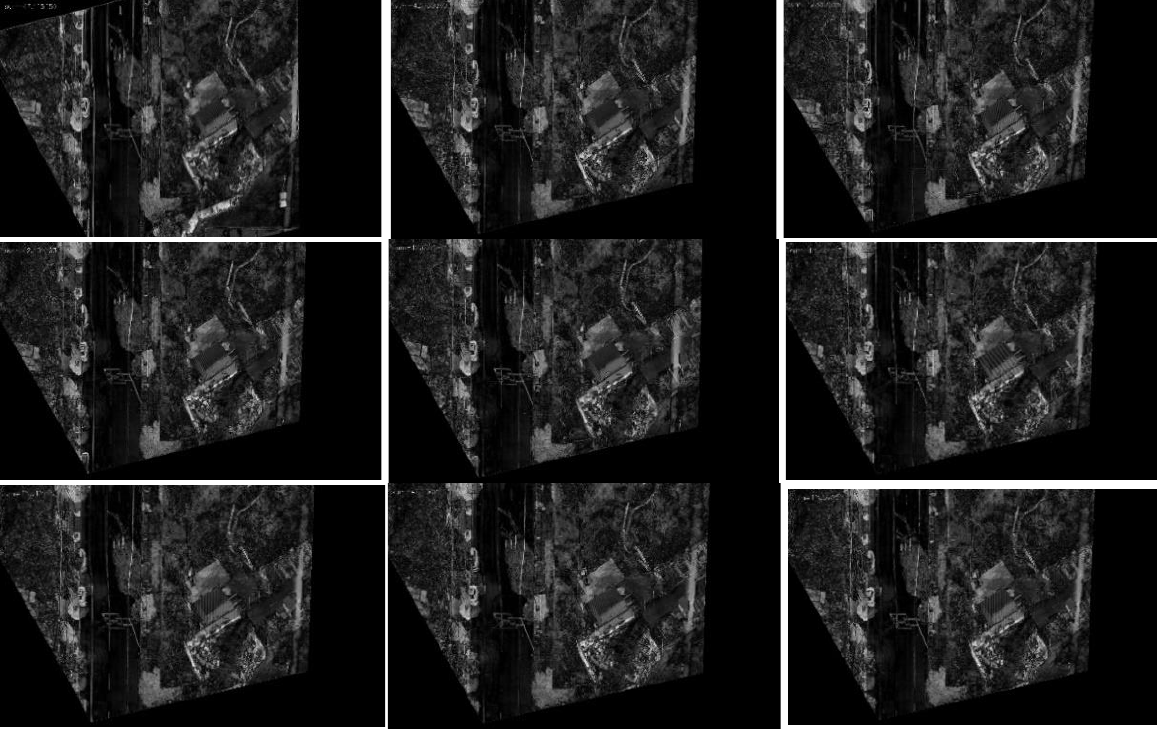
Figure 24. Registration image (without updating the map features).